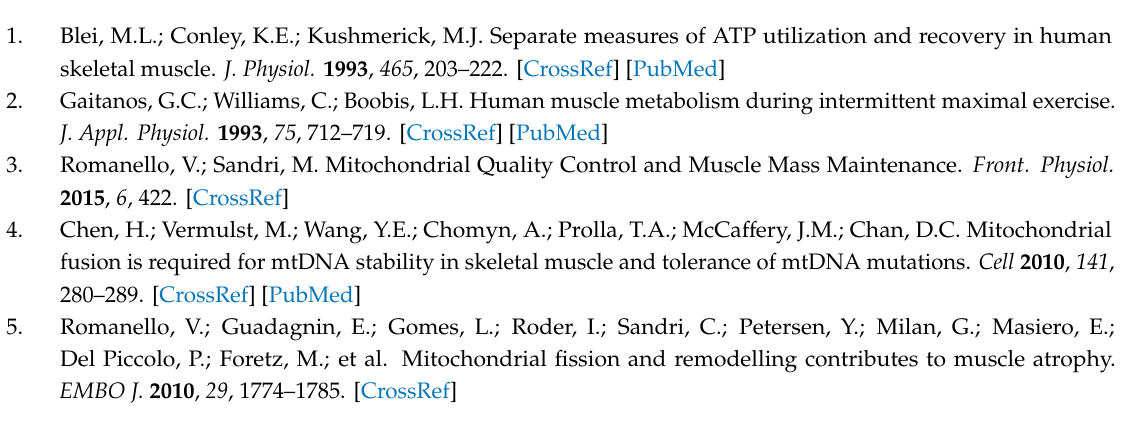
Figure S1, Figure S2, Figure S3, Table S1: List of primers used for quantitative PCR analysis, Table S2: Antibodies used in this study Table S3: Genotyping distribution of MLC-DKO mice, Table S4: Comparison between inducible muscle-specific Opa1, Drp1 and DKO phenotype and signaling, and Table S5: Comparison between DKO muscles and sarcopenic